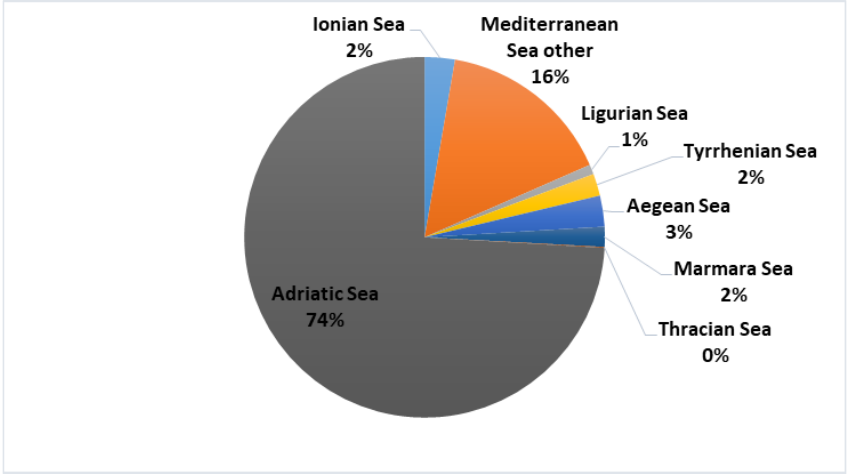
Figure A13. Percentages of BW discharged in the Port of Ploče sourced from the Mediterranean Sea.